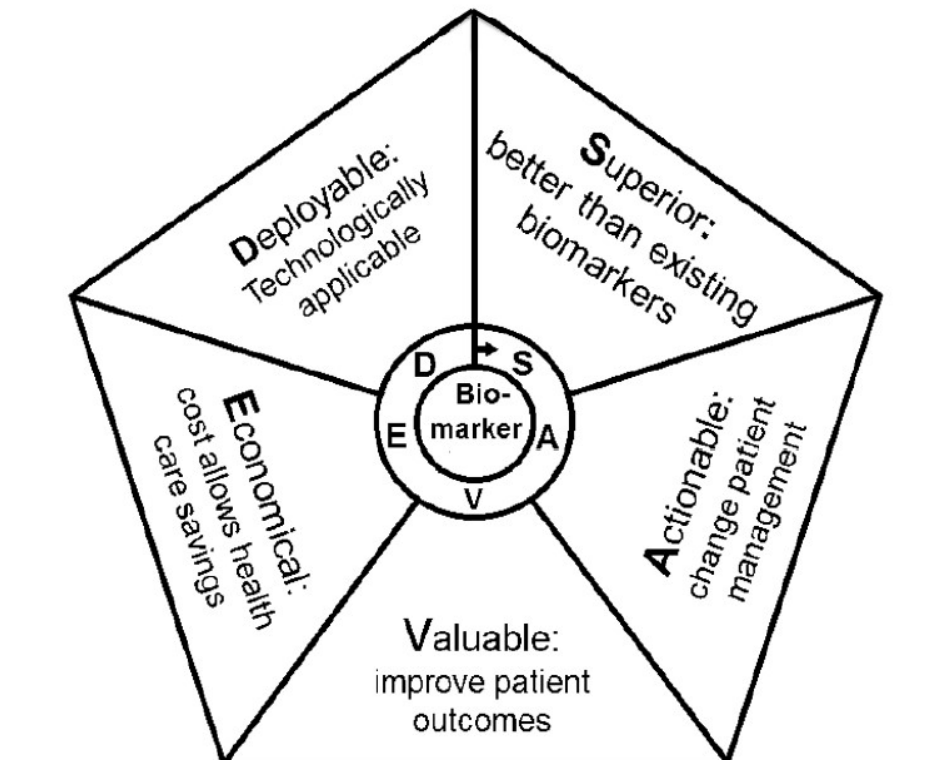
Figure 2. The “SAVED” approach to characterize an “ideal” biomarker. See text for details.